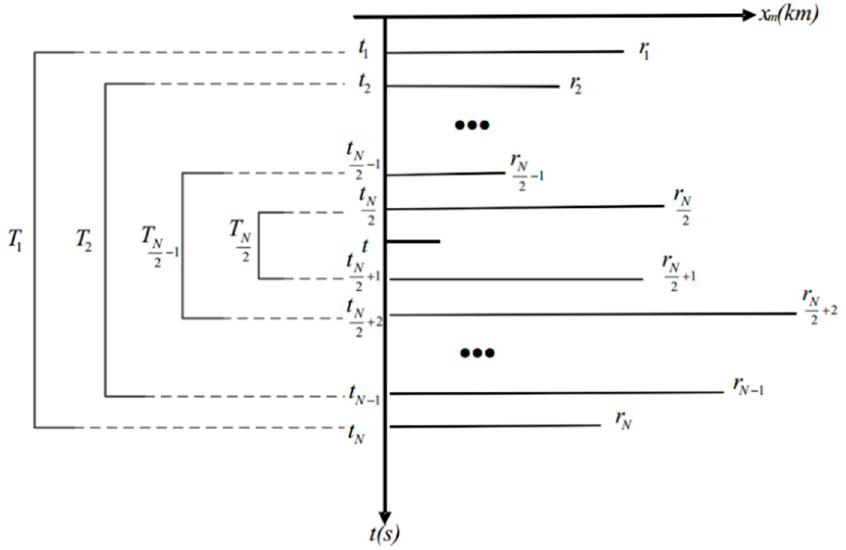
Figure 3. Multiple layers reflection coefficient model.